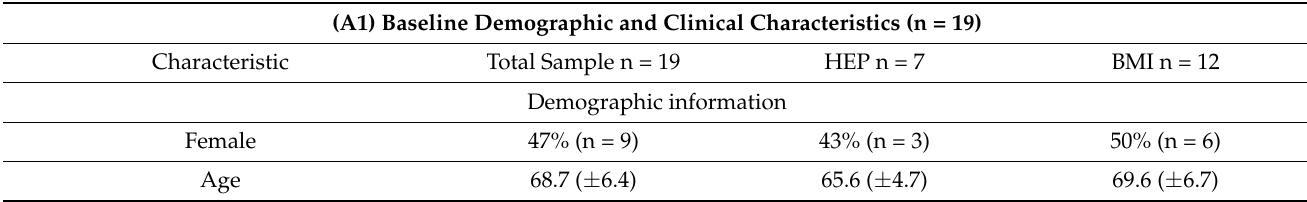
Table A1. Brief Mindfulness Intervention (BMI) and Health Enhancement Program (HEP). (A1) Baseline Demographic and Clinical Characteristics (n = 19)